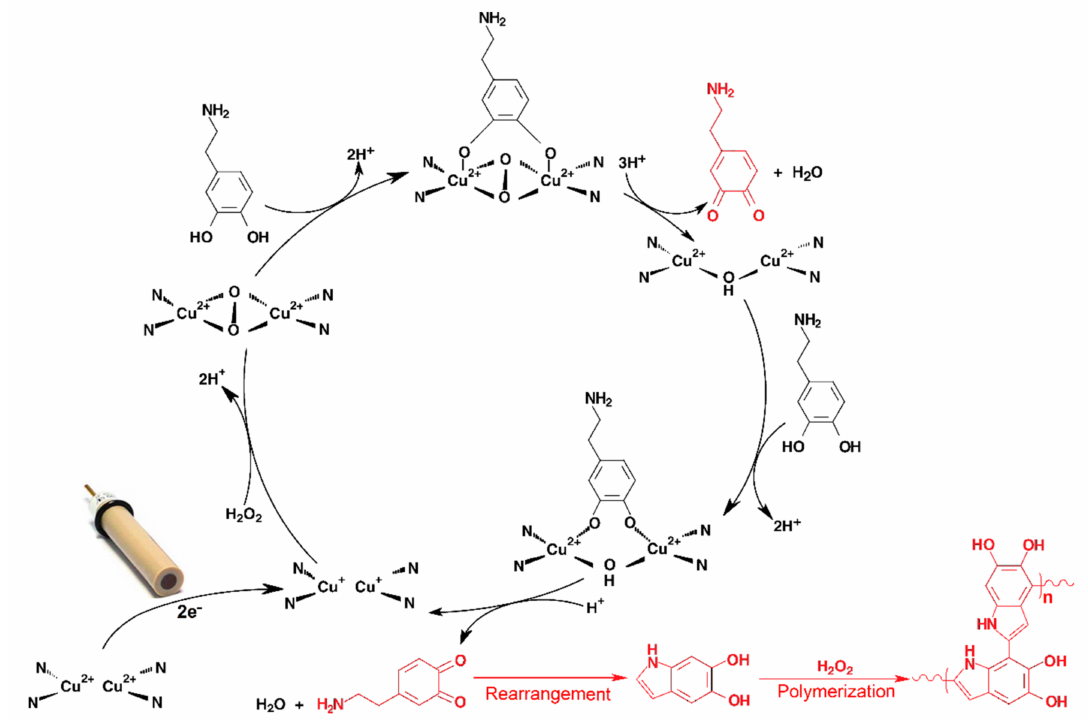
Figure 7. Proposed mechanism for dopamine oxidation catalysed by [Cu(bipy) 2 Cl]Cl · 5H 2 O in the presence of H 2 O 2